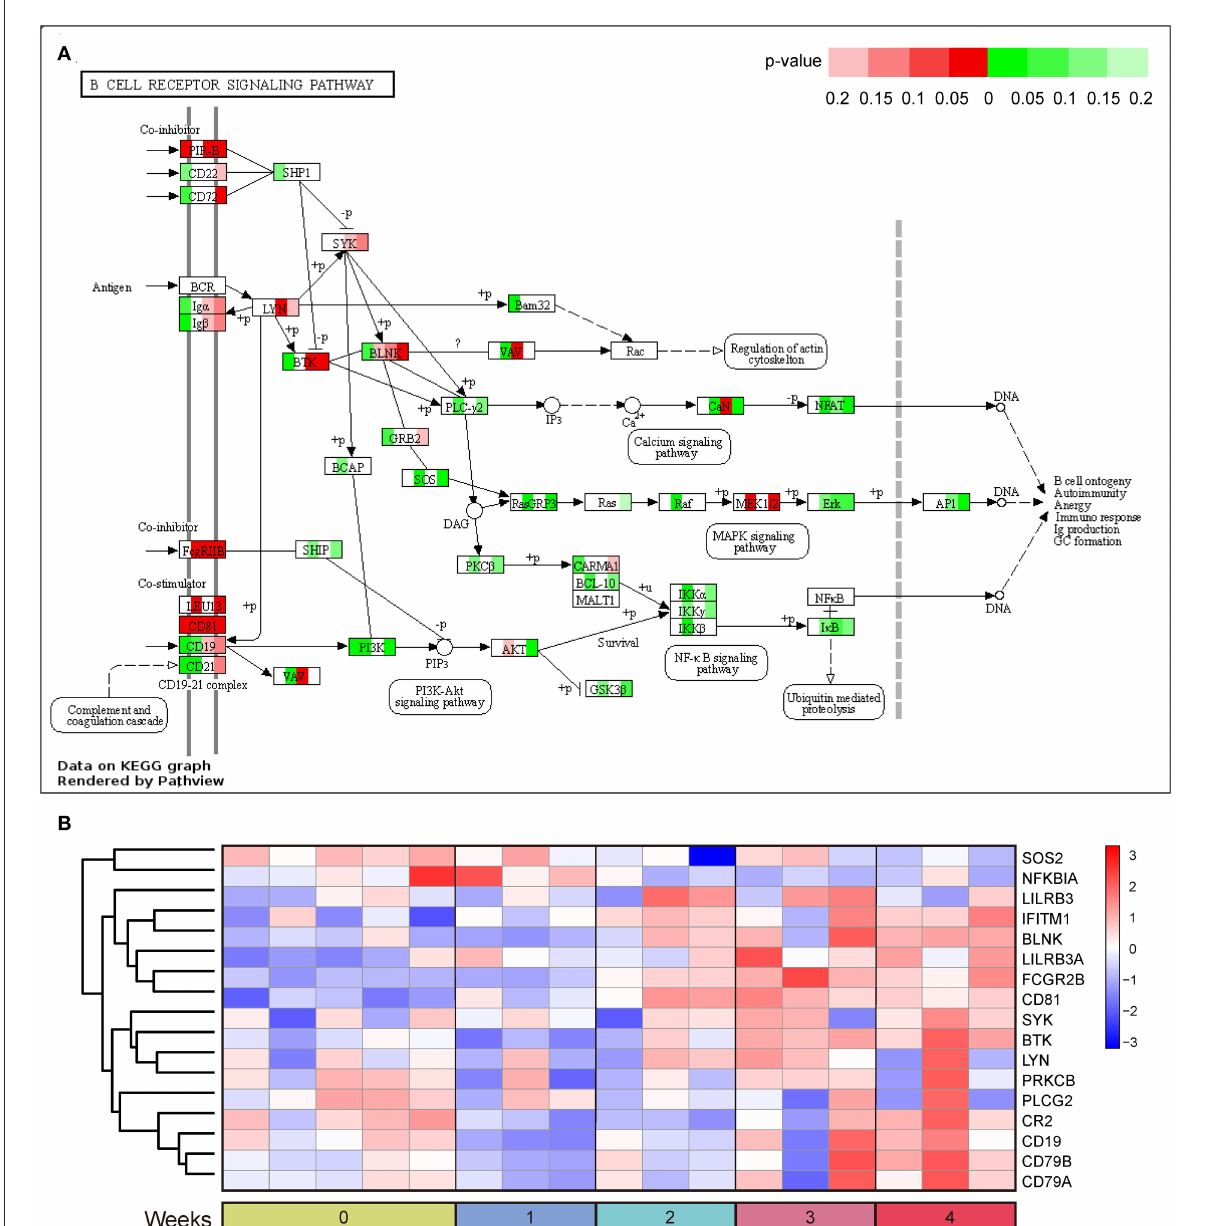
FIGURE4 B-cell receptor signaling pathway in response to monocrotaline (MCT) treatment. (A) The integration and visualization of gene expression in B-cell receptor signaling pathway using modified Pathview. Each colored box represents the comparison of MCT treatment at week 1, 2, 3, and 4 with control, respectively. Color represents P -value for each comparison of MCT treatments with control (unpaired t -test), red and green represent the elevation and decrease of corresponding gene expression, respectively, while white represents P ≥ 0.2 or not detected. (B) Heatmap plot of differentially expressed genes in B-cell receptor signaling pathway. Rows and columns represent gene expression levels and each sample, respectively. Red and blue represent the elevation and decrease of corresponding gene expression,